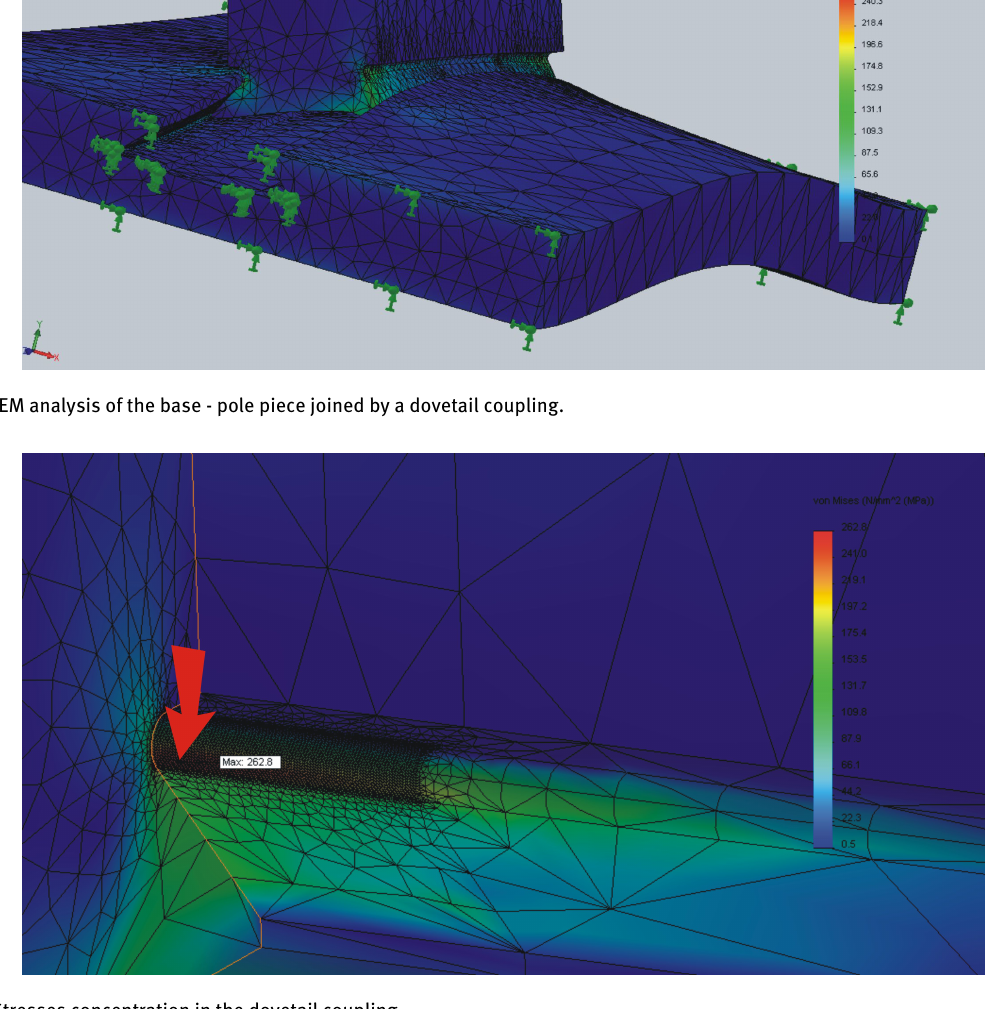
tem of forces. In this case the forces are applied perpendic- ularly to the nine bottom surfaces of each retention